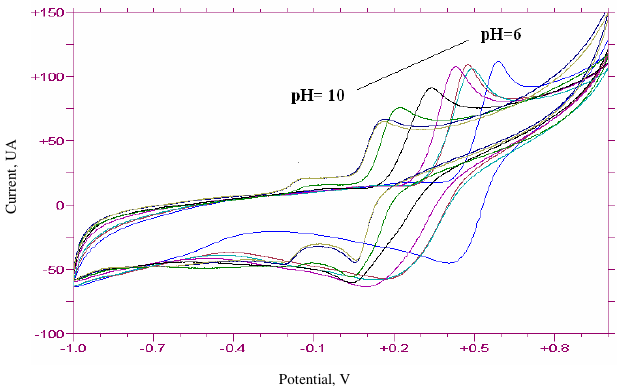
Figure 2. Cyclic voltammograms with varying pH levels for GC electrode modified with modified MgB /GC in 0.1 M KH P0 . potential scanning in the positive direction from - 2 2 4 1000 to +1000 mV vs. Ag/AgCl at a scan rate of 100 mV/s